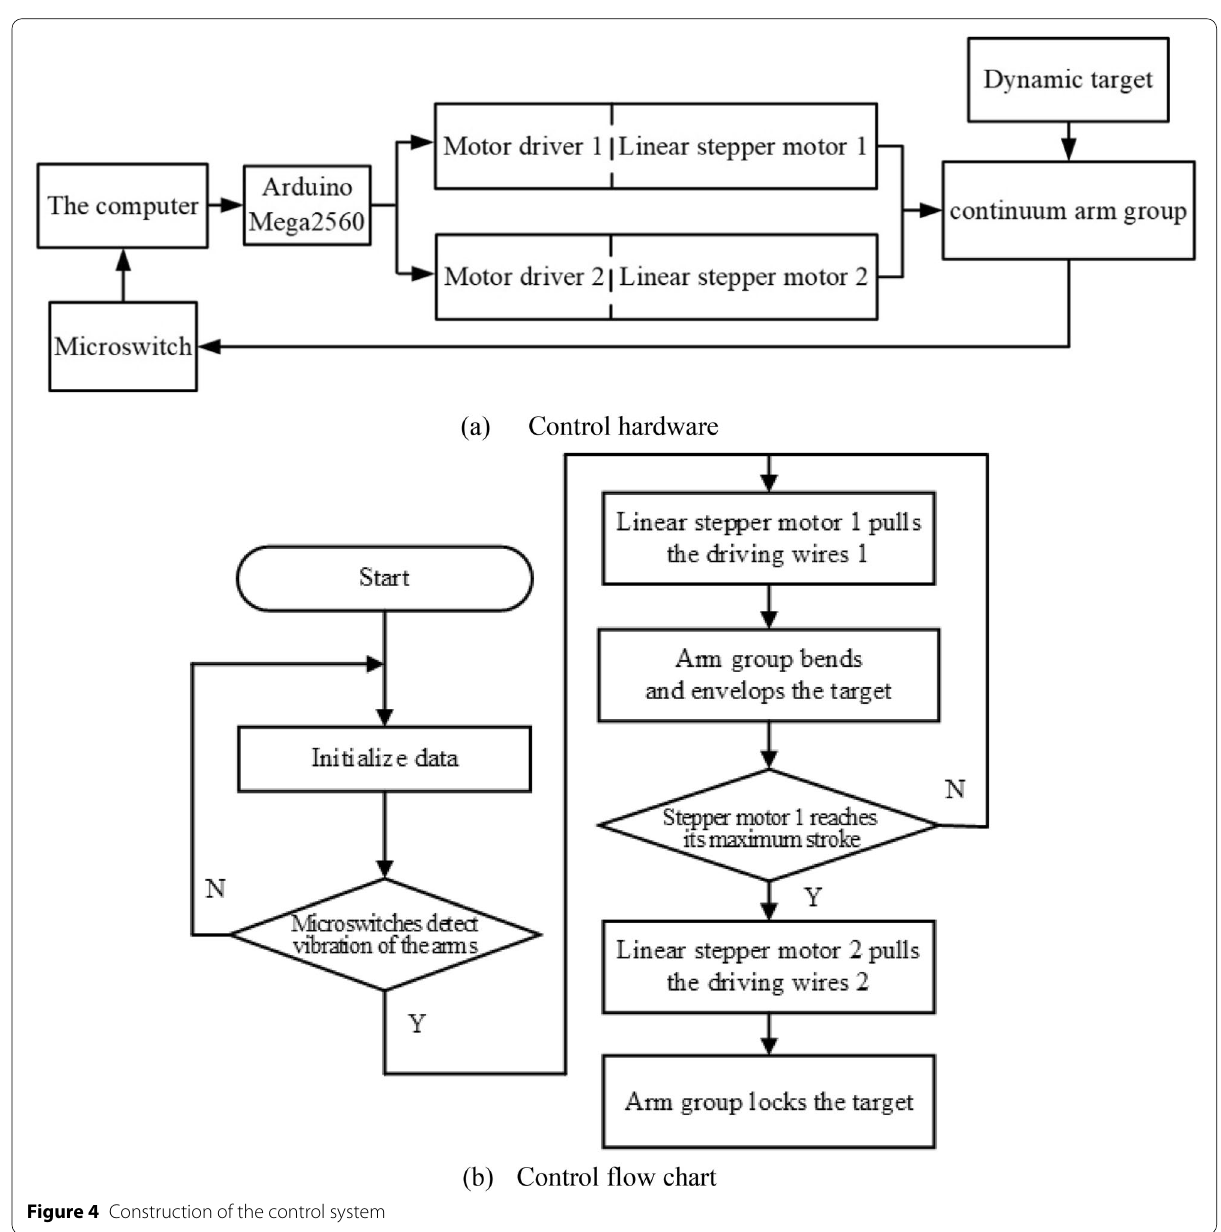
Figure 4 Construction of the control